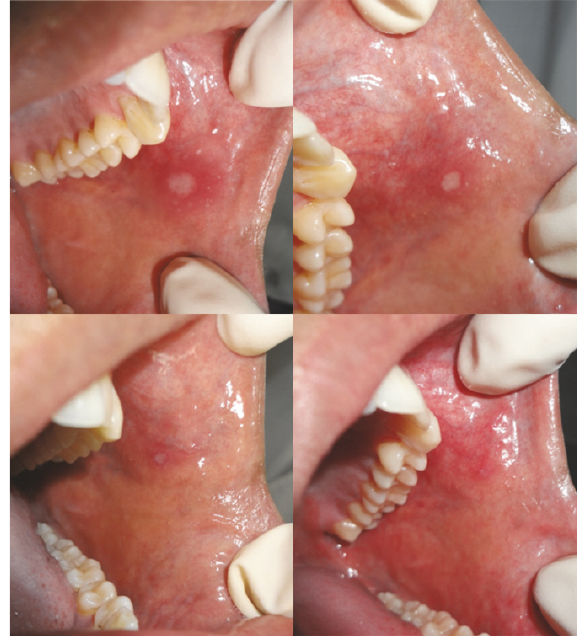
Figure 2: Ulcer healing seen in group A.